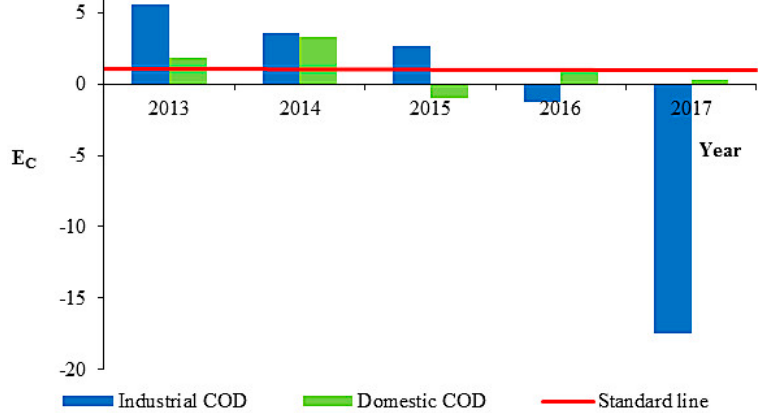
Figure 9. The elasticity coefficients between industrial (or domestic) COD emissions and wastewater emissions.